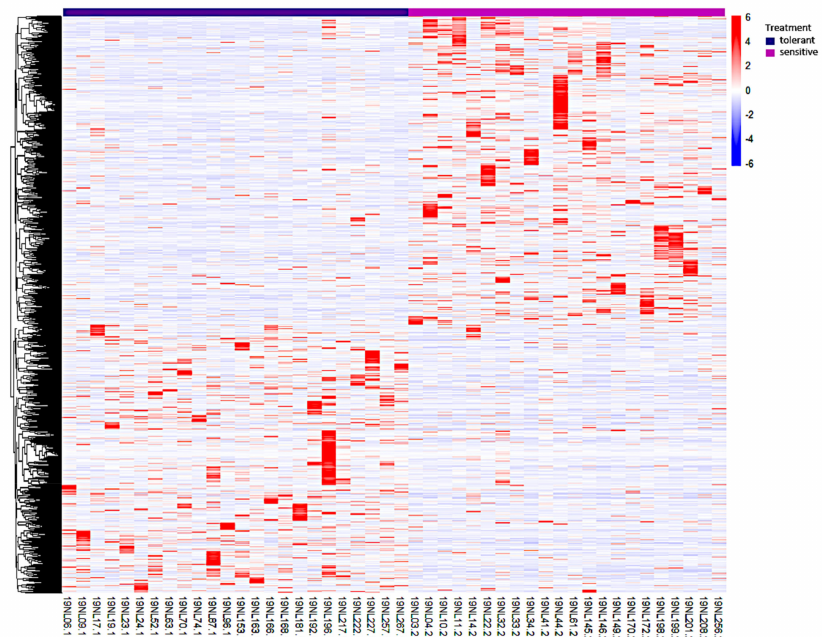
Figure 3. Heatmap showing the clustering analysis of 2237 common cold-responsive genes. The x -axis represents different maize samples. The purple color denotes the cold-tolerant lines while the pink color represents the cold-sensitive lines. The red and blue color scale represents high and low expressions,